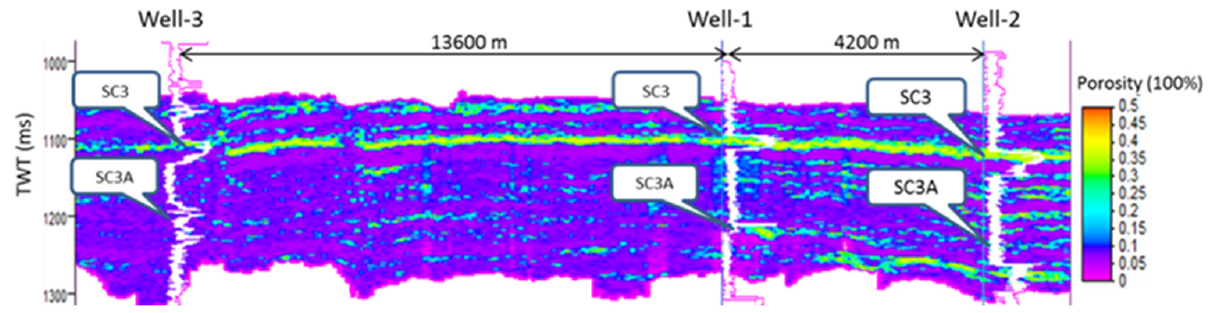
Figure 16. Inverted porosity inline cross section passing near Well 1, Well 2 and Well 3 location. Well 2 and Well 3 are blind wells.